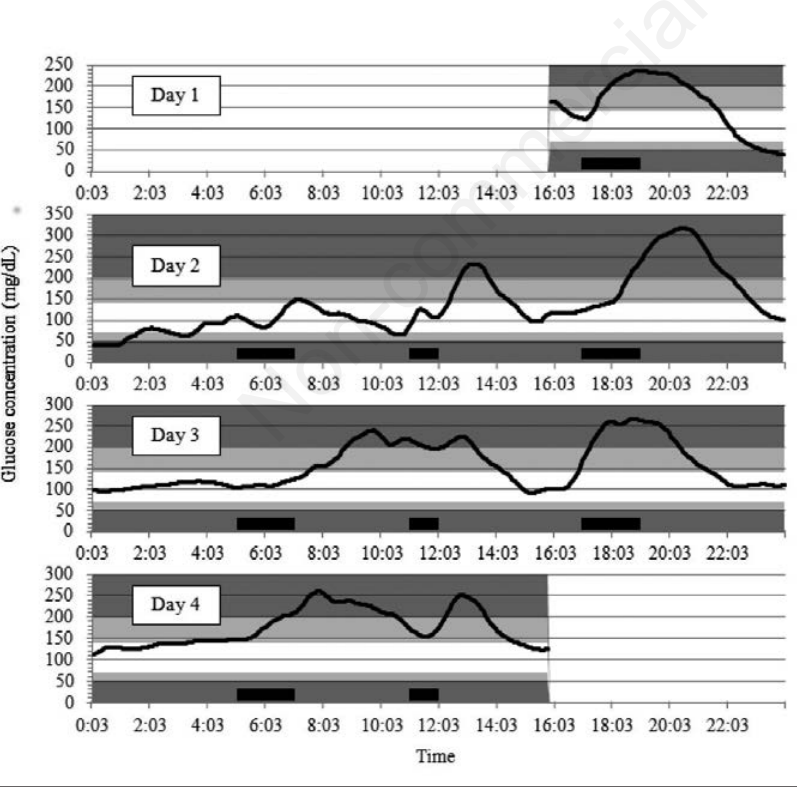
Figure 1. Result of CGM in case 8. Glucose fluctuation, featured by nocturnal decline and postprandial elevation of glucose concentration, was observed in examination for 72 hours. The recording started at 16:03 on day 1. Black bands represent feeding time of enteral nutrition. Abnormal level of glucose was noted by bands in light gray (51-70 mg/dL or 140-199 mg/dL) as mild abnormalities and dark gray ( ≤ 50 mg/dL or ≥ 200 mg/dL) as severe